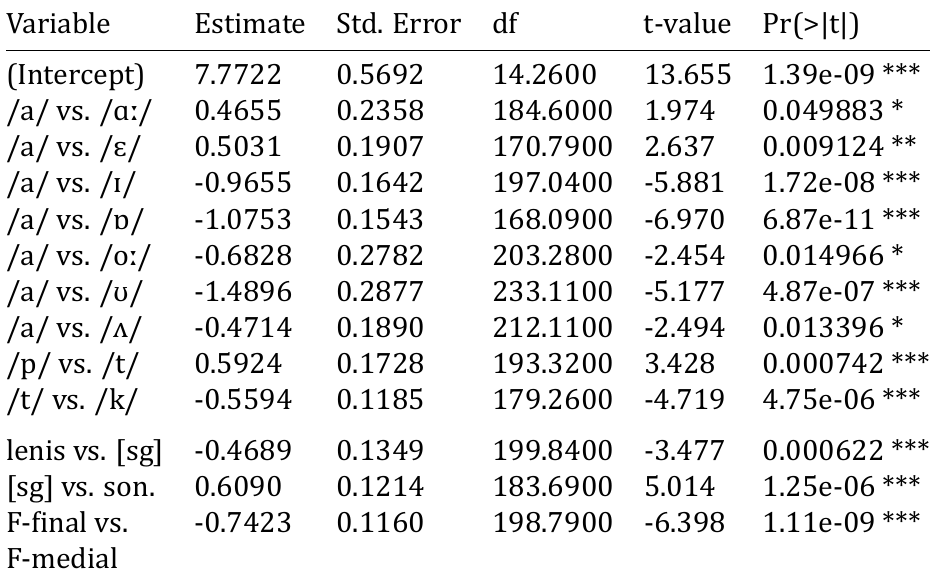
Table 4: Statistical results for breathiness duration